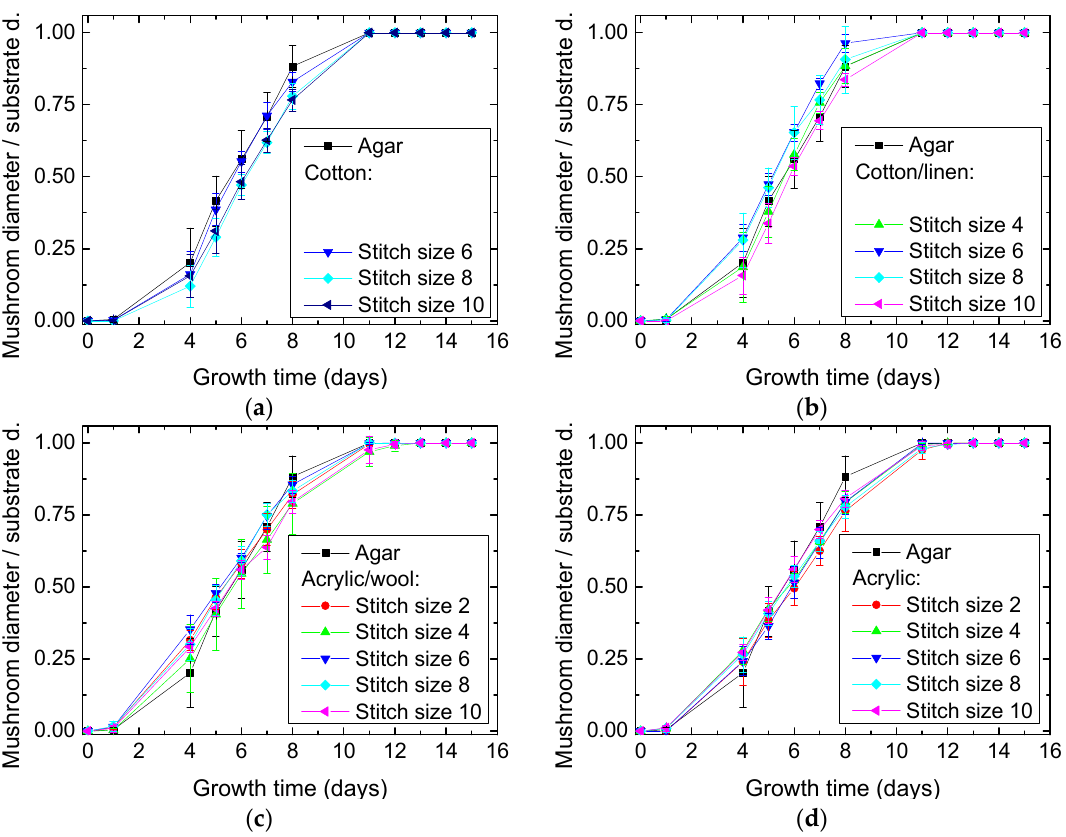
Figure 5. Growth process (diameters normalized to the substrate diameters) of Pleurotus ostreatus mycelium on dip-coated substrates from different materials: ( a ) cotton; ( b ) cotton/linen; ( c ) acrylic/wool; ( d ) acrylic.